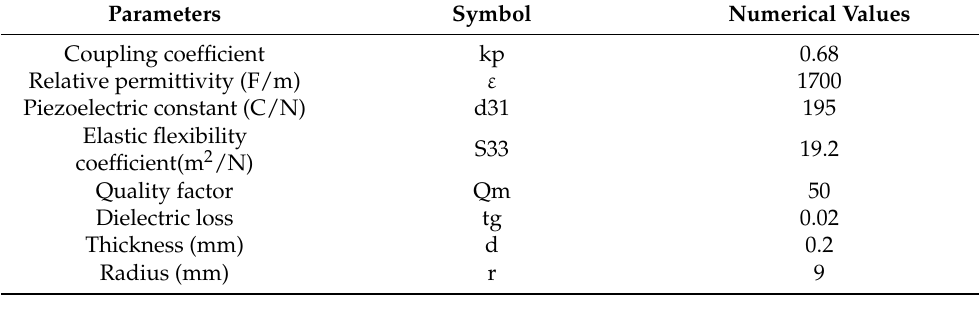
Table 3. Main parameters of piezoelectric ceramics.